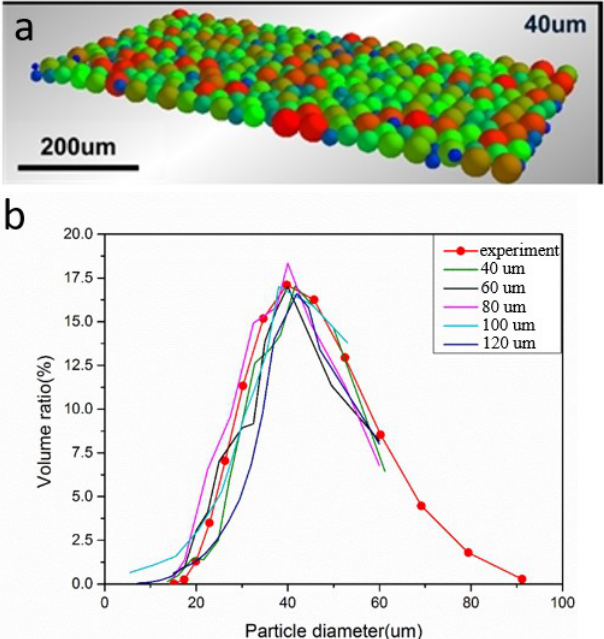
Figure 2. Geometric model of powder layer with a thickness of 40 µ m ( a ); particle size distribution in simulation and that of actual powder particle size distribution in experiment ( b ).